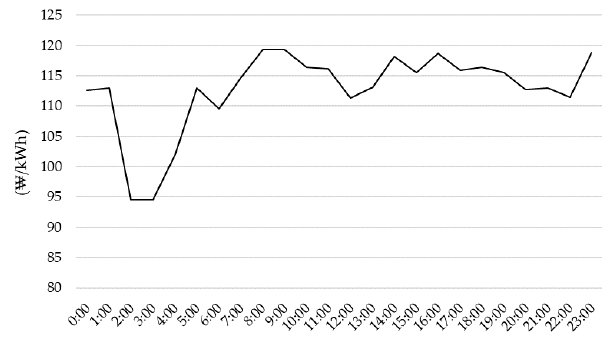
Figure 6. SMP data for simulation.